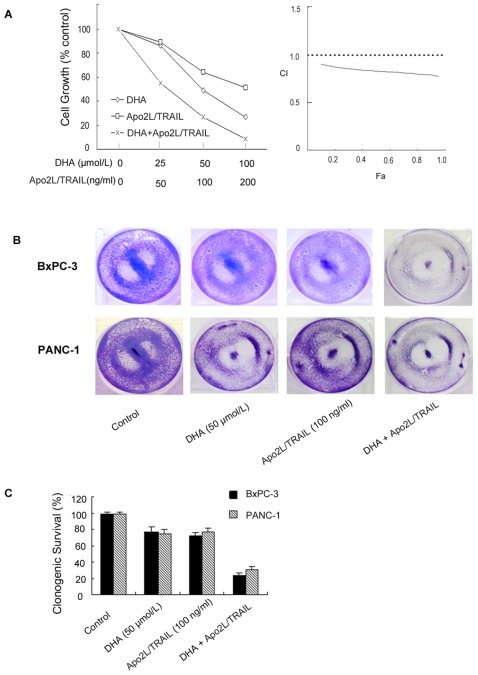
DHA synergistically enhances Apo2L/TRAIL-induced cell death in BxPC-3 cells.(A) Cells were treated with DHA alone, Apo2L/TRAIL alone or a combination of the two agents and incubated at 37°C for 72 h. The viability of the cells was assessed using the MTT method. Combination index (CI) versus fraction affected (Fa) plots obtained from median-effect analysis of Chou-Talalay. A CI>1 indicates antagonism,  = 1 indicates additivity, and <1 indicates synergy. (B) The clonogenic assay was performed as described in the Materials and Methods section. The cells were treated with DHA (50 µmol/L) alone, Apo2L/TRAIL (100 ng/ml) alone or the combination of the two drugs for 24 h and washed with PBS. The cells were then incubated for an additional 7 d and stained with crystal violet. (C) Clonogenic survival is presented as the percentage of surviving colonies formed in drug-treated cells with respect to untreated cells.